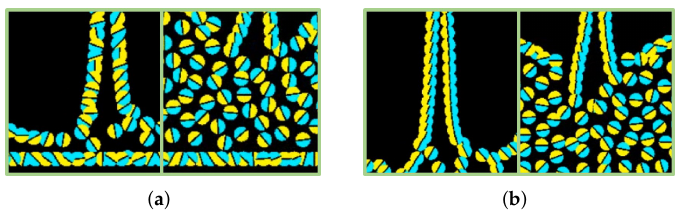
Figure 7. Comparison of close-up views in Figure 6. The related video has been submitted as Supple- mentary Material. ( a ) Our method. ( b ) Without angular